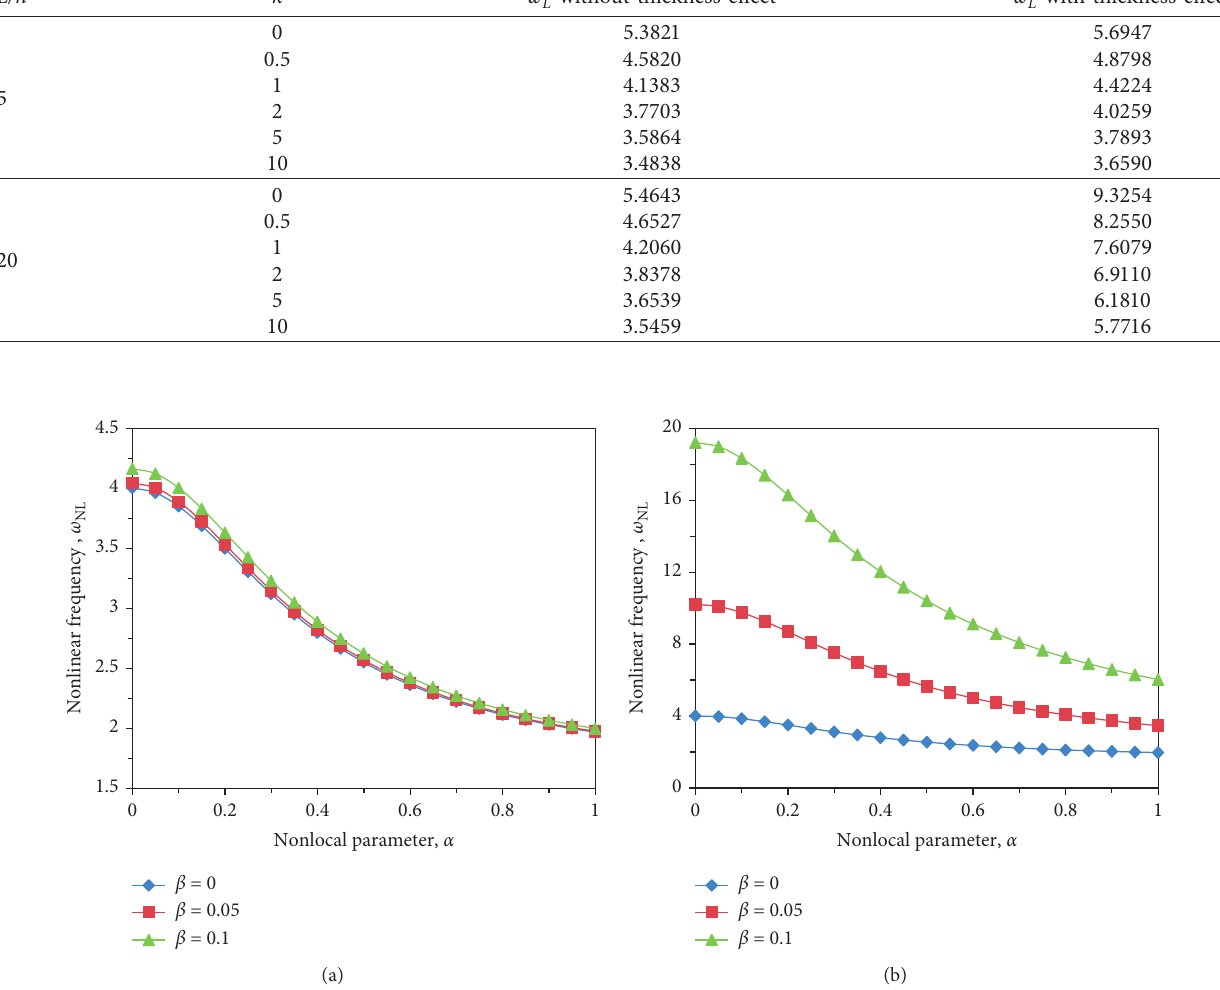
Figure 2: The variation of the nonlinear frequencies of the FG nanobeams to the nonlocal parameter for k � 5, L / h � 15, and V without thickness effect; (b) with thickness